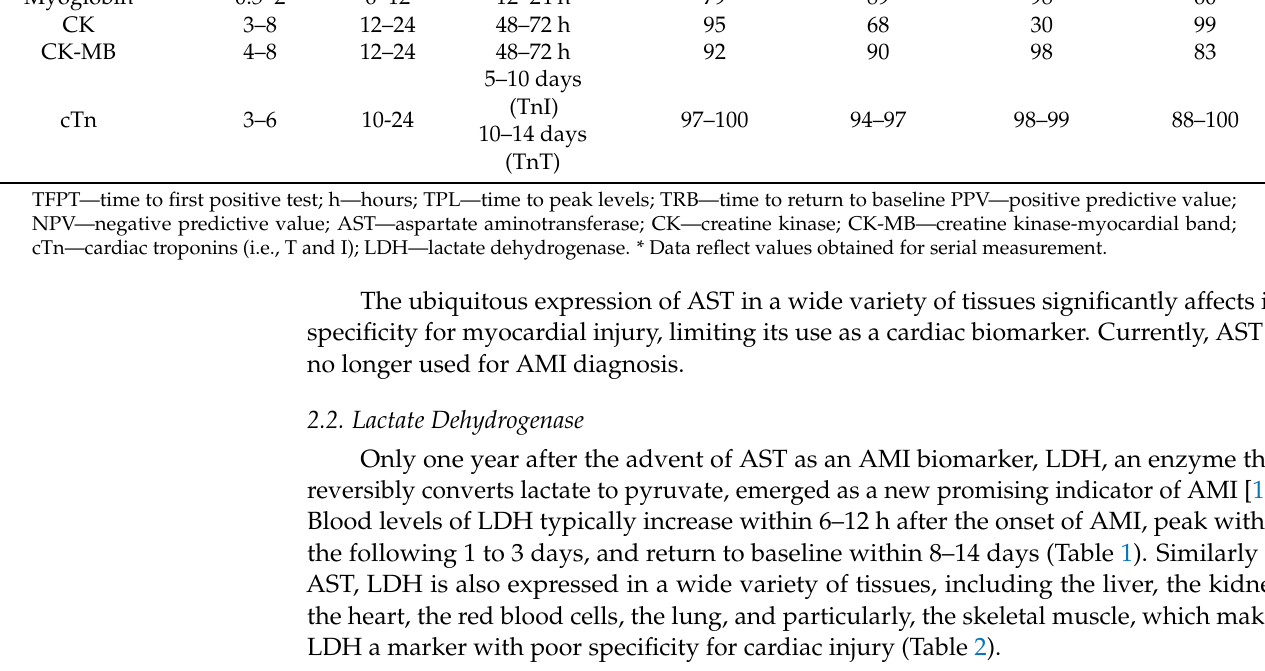
Table 2. Most common non-acute myocardial infarction-related causes of cardiac biomarkers elevation. Biomarker Potential Causes of Elevation (Others Than Acute Myocardial Infarction)